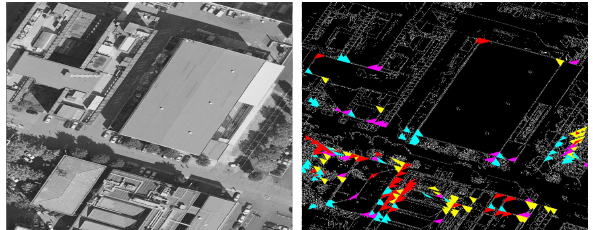
Figure 2: Corners detection. Left: original image; right: corners detected and colored according to the